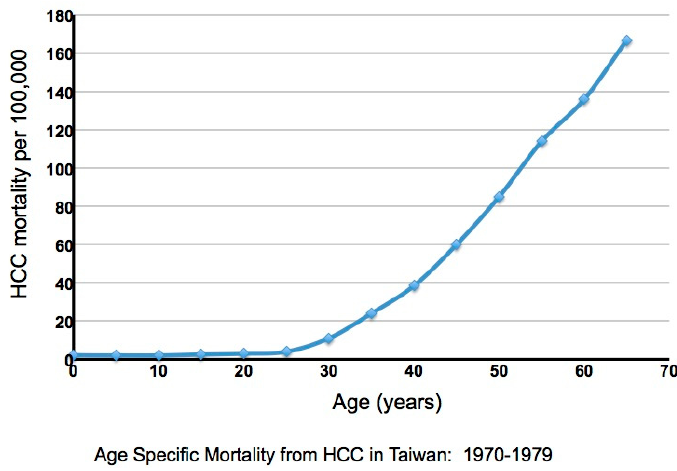
Figure 1. Age specific hepatocellular carcinoma (HCC) mortality in Taiwan. Adapted from Figure 2 of a paper by R.P. Beasley